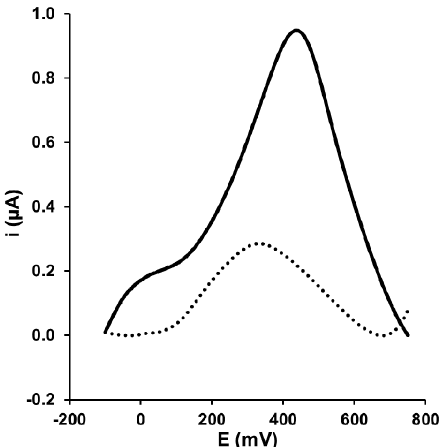
Figure 4. An example of Osteryoung square-wave voltammetry (OSWV) curves recorded with gold electrode HSCX-COOH/MET in the presence of 10 pM DA in 0.2 M McIlvain buffer pH 7.0 (dotted line) and pH 2.0 (solid line). The OSWV was performed with step potential 1 mV, square-wave frequency 25 Hz, and square-wave amplitude 50 mV.